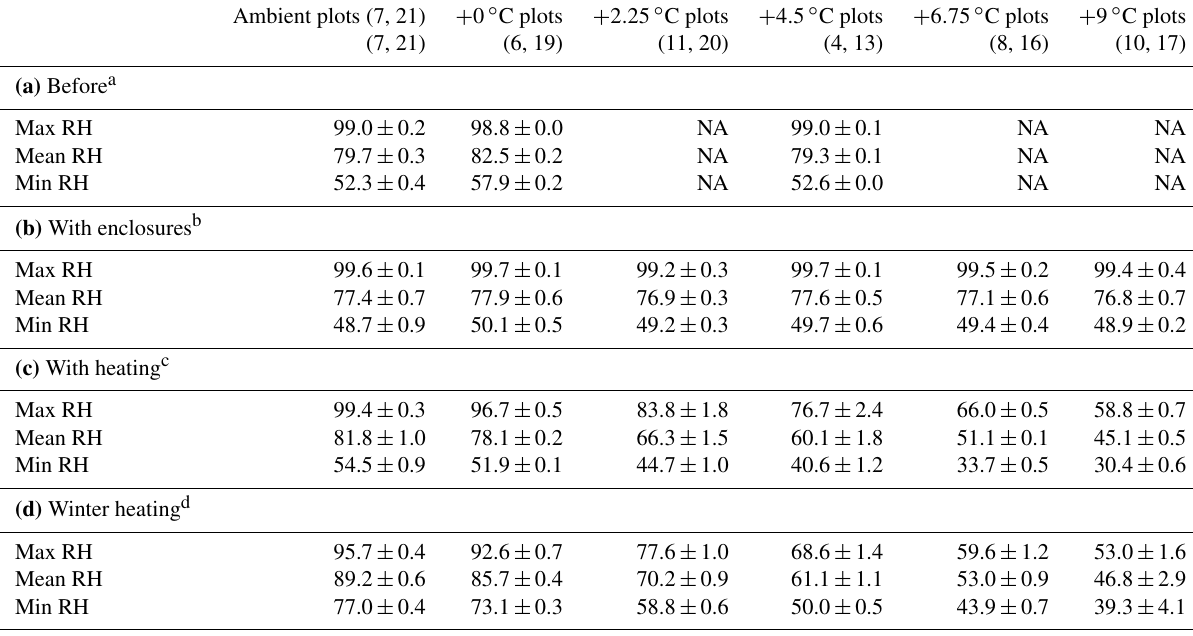
Table 4. Plot-to-plot variation in mean daily relative humidity ± SD (RH; %) at + 2m before the construction of enclosures (a) , with enclo- sures (b) , with active air-warming treatments engaged during warm periods (c) and with heating during winter (d) . Ambient plots (7,